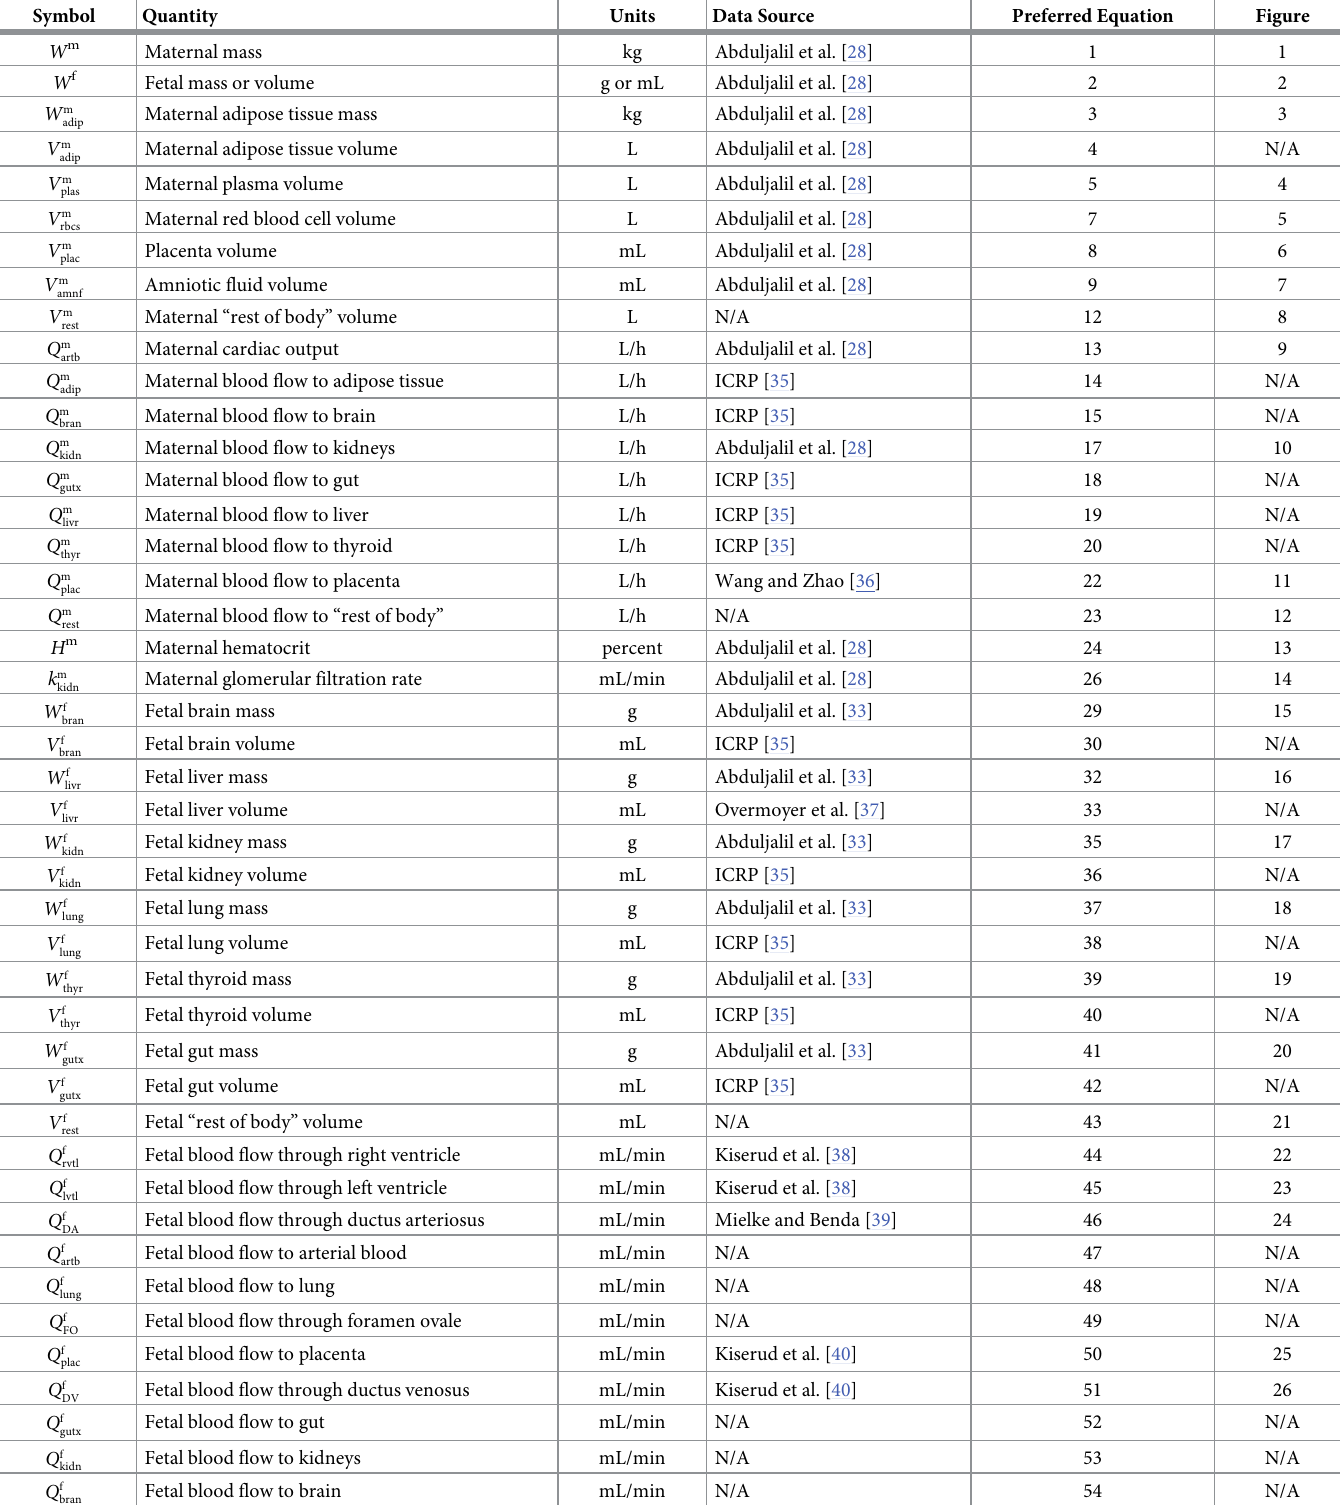
Table 2. Data sources, preferred models, and relevant figures for various quantities of interest.